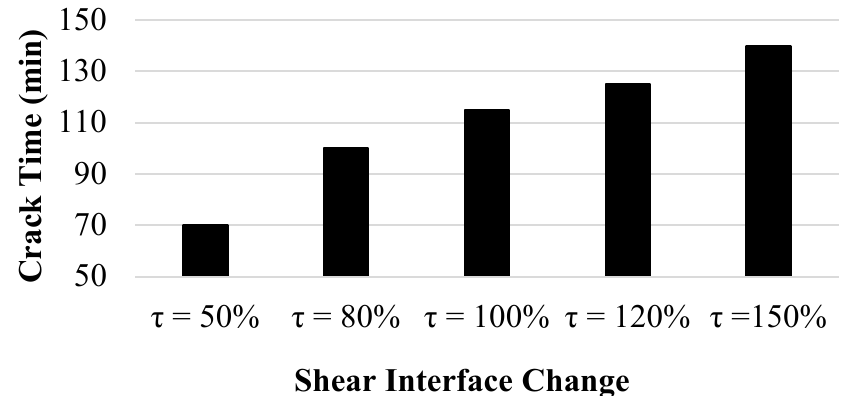
the minimum interface shear stress.